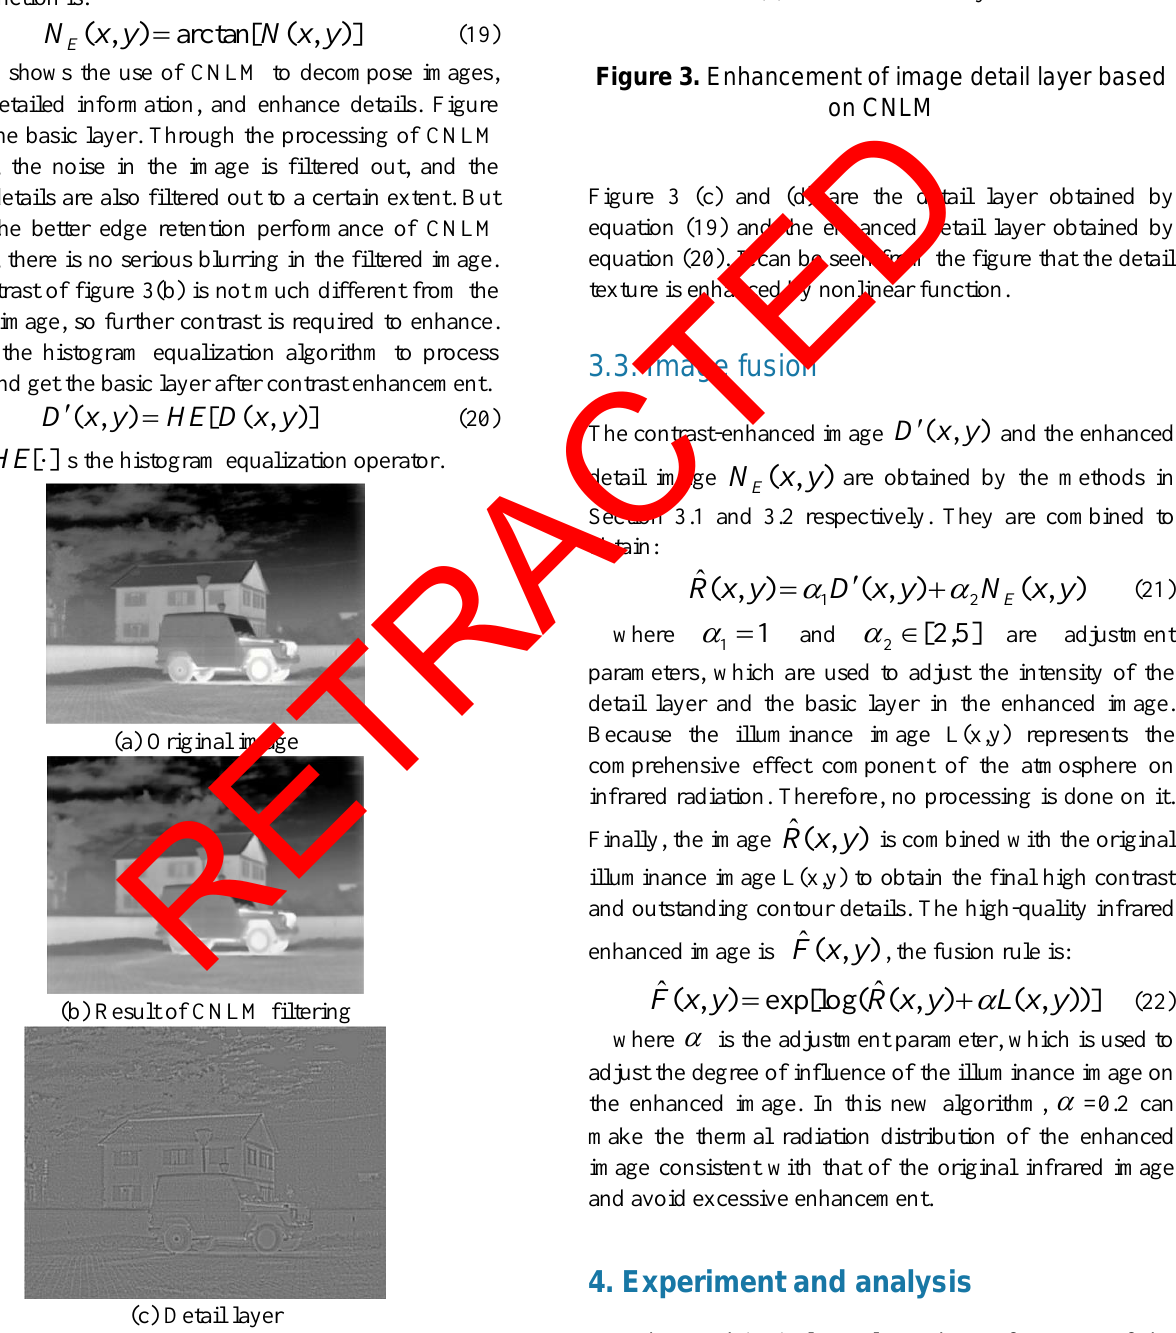
(d) Enhanced detail layer